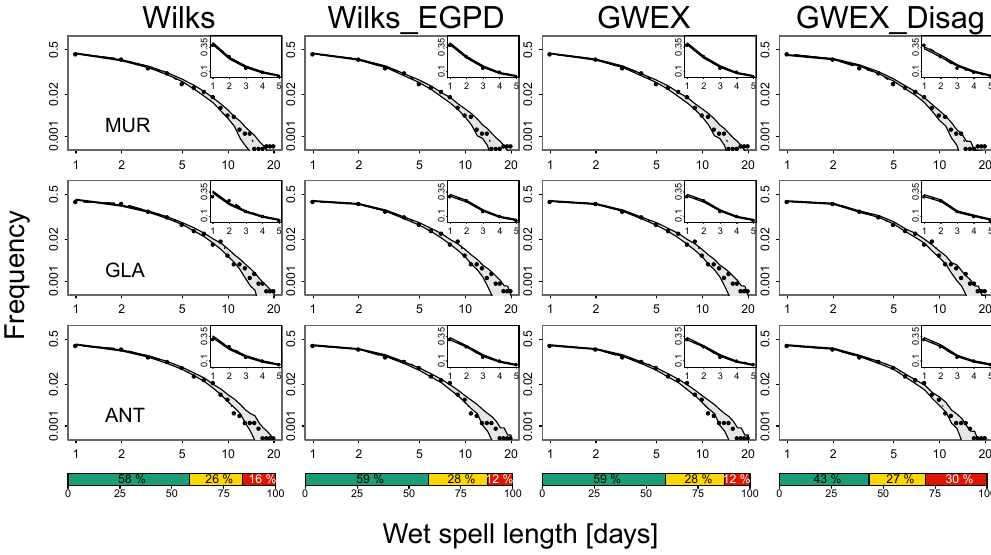
Figure 9. Distribution of wet spell lengths at the stations: the 90% probability limits are shown. Overall performance is represented by the indicated percentages of good, fair, and poor performance for all sites. Inset plots provide a zoom for durations of 1 to 5